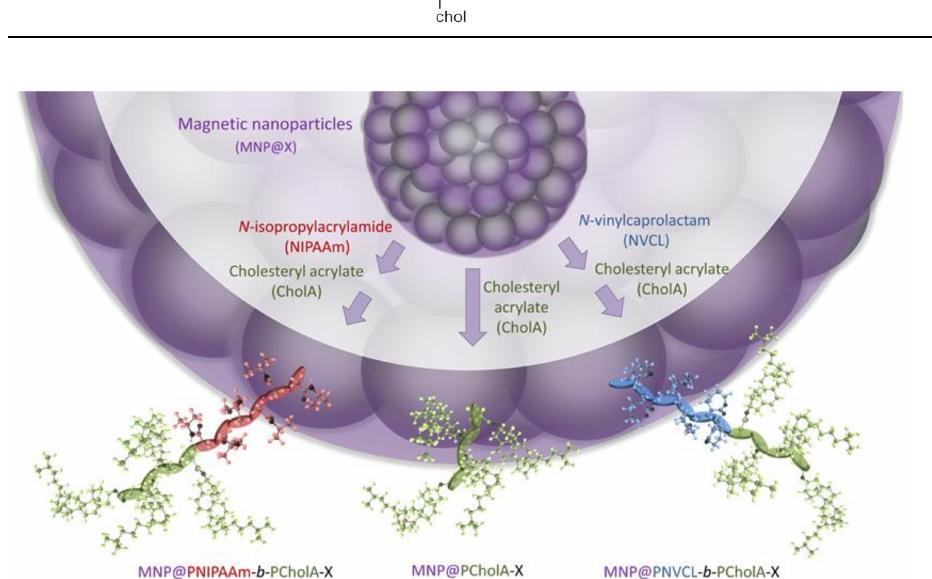
Figure 1. Types of polymeric shells formed on the surface of